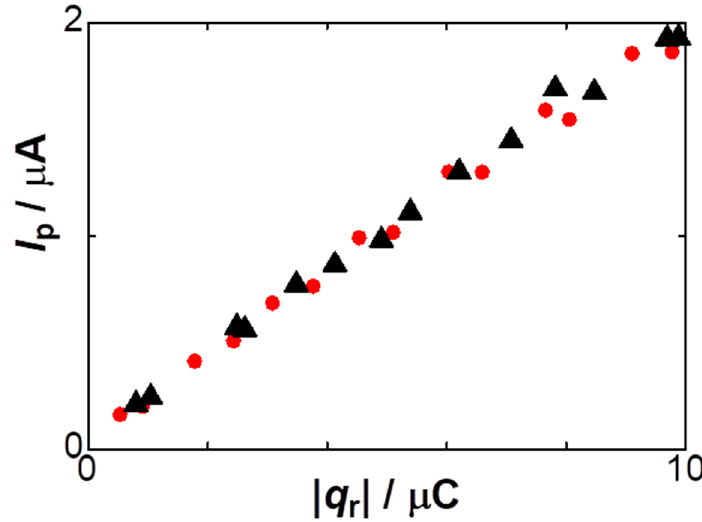
Figure 7. Dependence of the anodic peak currents on | q r | in the solutions including 2 mM NaNO 3 (triangles) and 50 mM NaNO 3 (circles) with 5 mM AgNO 3 at v = 0.01 V s − 1 .